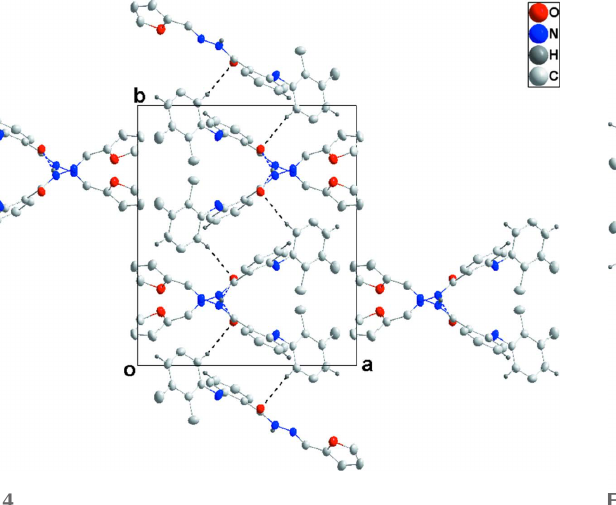
Figure 6 Packing view of (II) along the c axis with intermolecular C—H (cid:2)(cid:2)(cid:2) O hydrogen bonds shown as dashed lines.